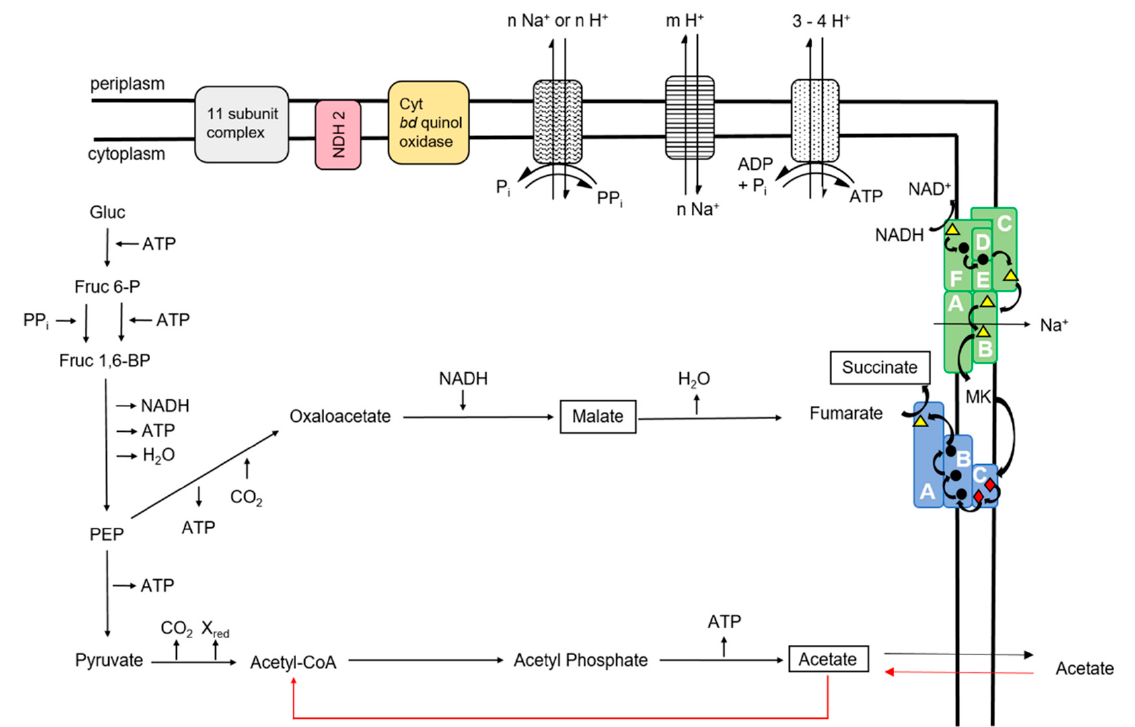
Figure 11. Energy-converting complexes and central carbon metabolism of P. bivia . Important products are highlighted by black boxes. Red arrows indicate reactions for the assimilation of acetate. Gluc = glucose; Gluc 6-P = glucose 6-phosphate; and PEP = phosphoenolpyruvate. Blue = fumarate reductase (QFR); green = Na + -translocating NADH:quinone oxidoreductase (NQR); dotted = F 1 F O ATPase; striped = Na + /H + antiporter; wavy = pyrophosphatase; yellow = cytochrome bd quinol oxidase; red = NDH2; and grey = 11-subunit complex related to NDHI (complex I). Subunits of NQR (A-F) and QFR (A-C) are indicated. Colored symbols in the protein complexes represent cofactors. Yellow triangle = flavin; black circle = iron–sulfur center; red diamond = heme b ; and MK = menaquinone. UNIPROT numbers of proteins are listed in Table S1 (electronic Supplementary Material).